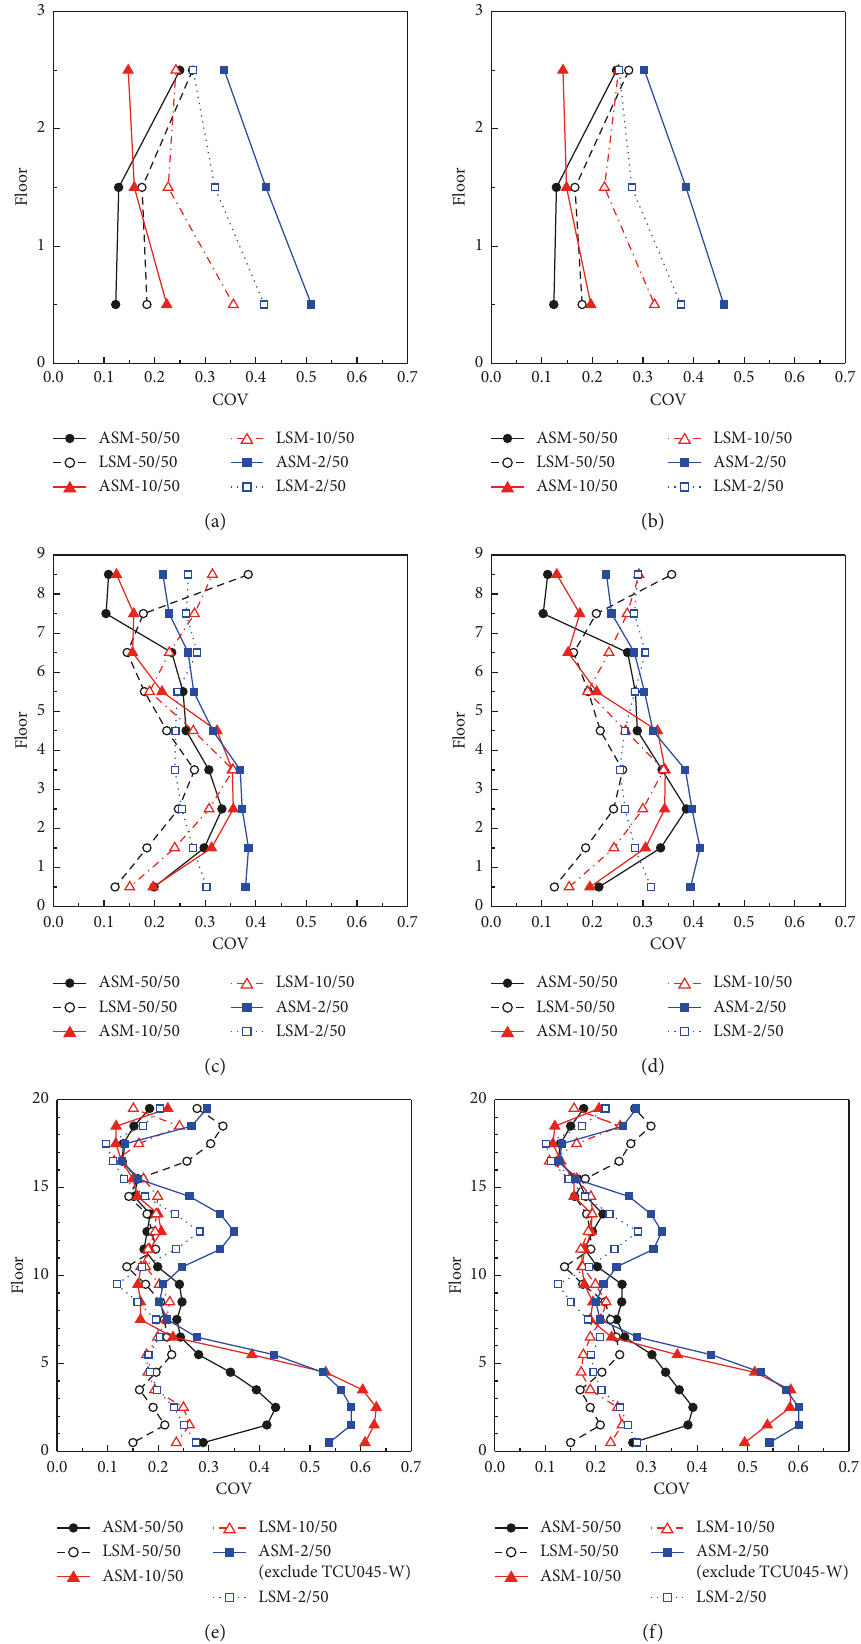
Figure 7: COVs of PIDR demands over the height of the 3-, 9-, and 20- structures at the 50/50, 10/50, and 2/50 hazard levels by both ASM and LSM methods: (a) 3-story, mean, (b) 3-story, median, (c) 9-story, mean, (d) 9-story, median, (e) 20-story, mean, and (f) 20-story,